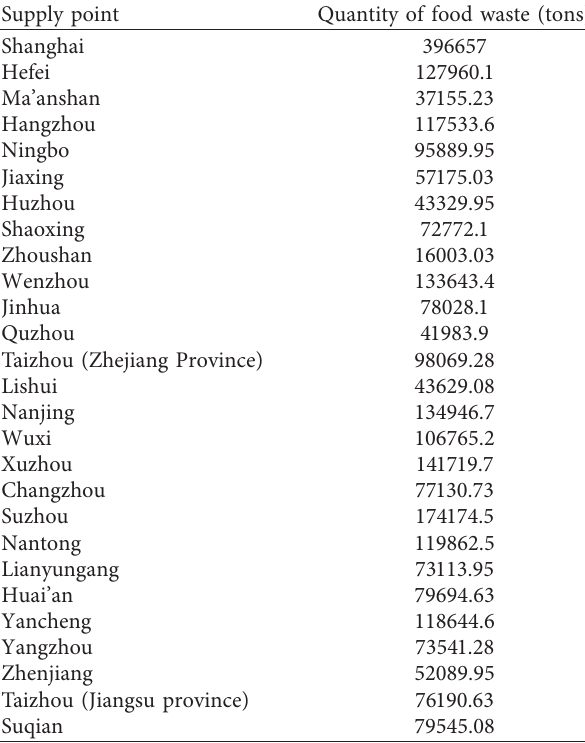
Figure 2: Solution idea of the two-stage stochastic programming model of WCO for biodiesel supply chain. Table 3: Total supply of recyclable kitchen waste in the Yangtze River Delta.